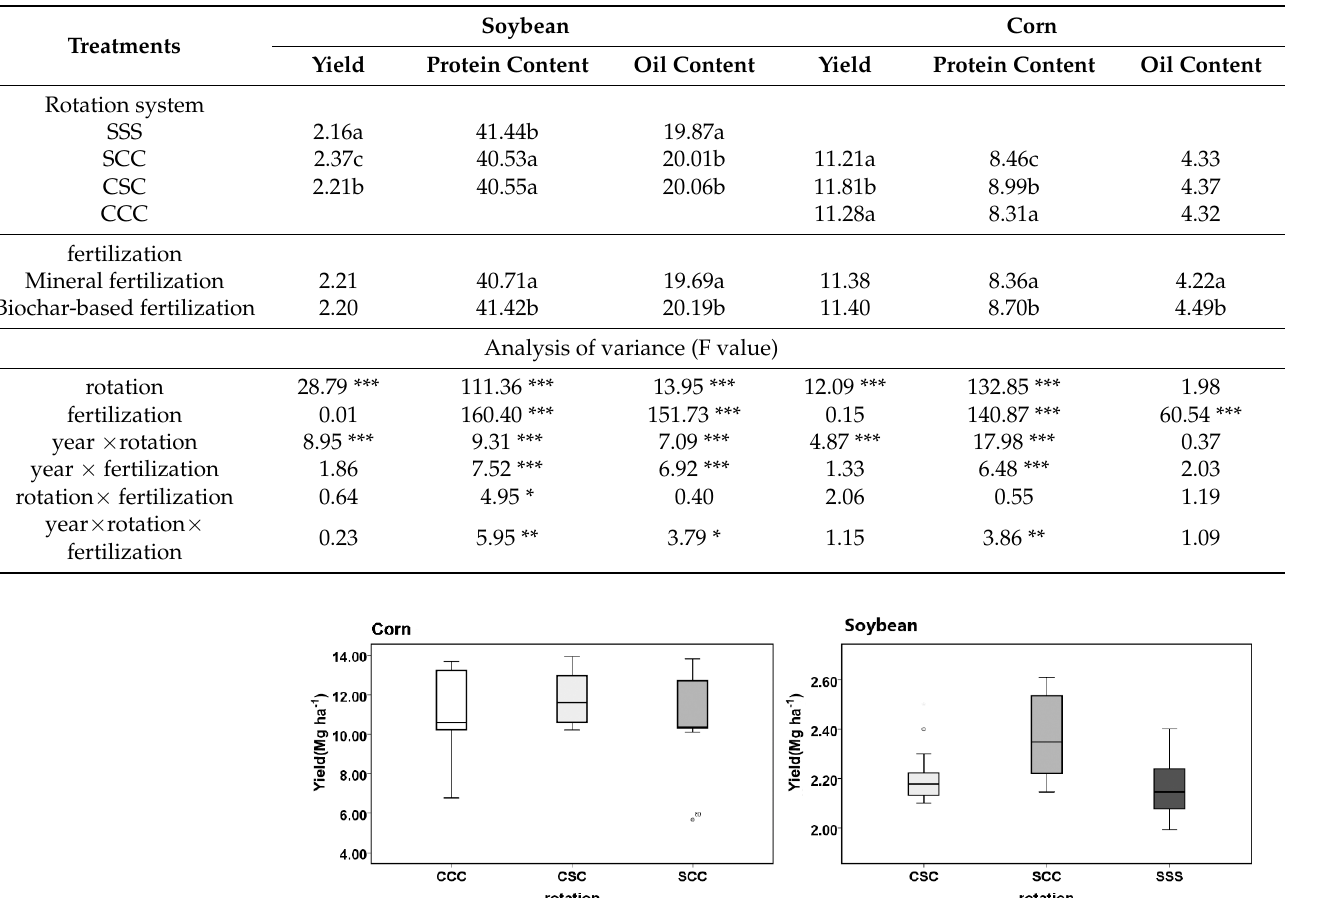
Table 2. Effect of rotations and fertilization on yield (Mg ha − 1 ) and protein and oil contents (%) in a corn–soybean rotation during the 7 years after the initiation of the experiment (2014–2020). Different